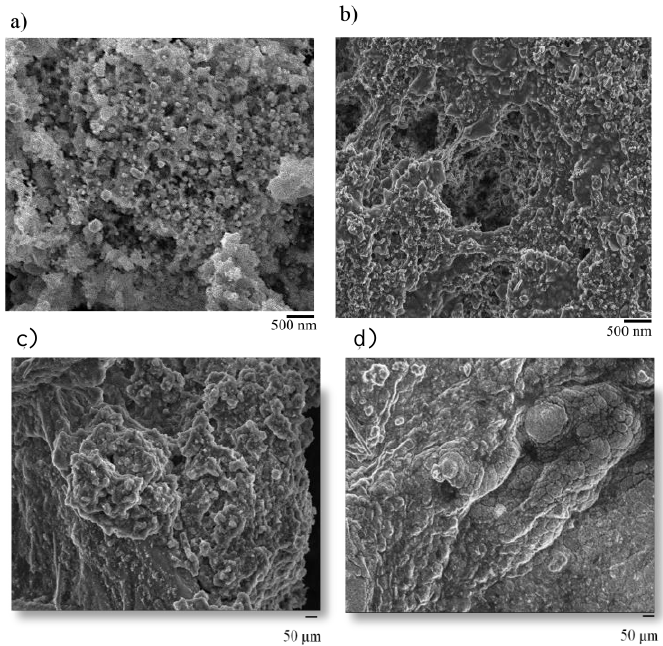
Figure 3. SEM images of ( a ) active material HCSi before testing, electrodes: ( b ) HCSi20, ( c ) HCSi40, ( d ) HCSi60 after testing.